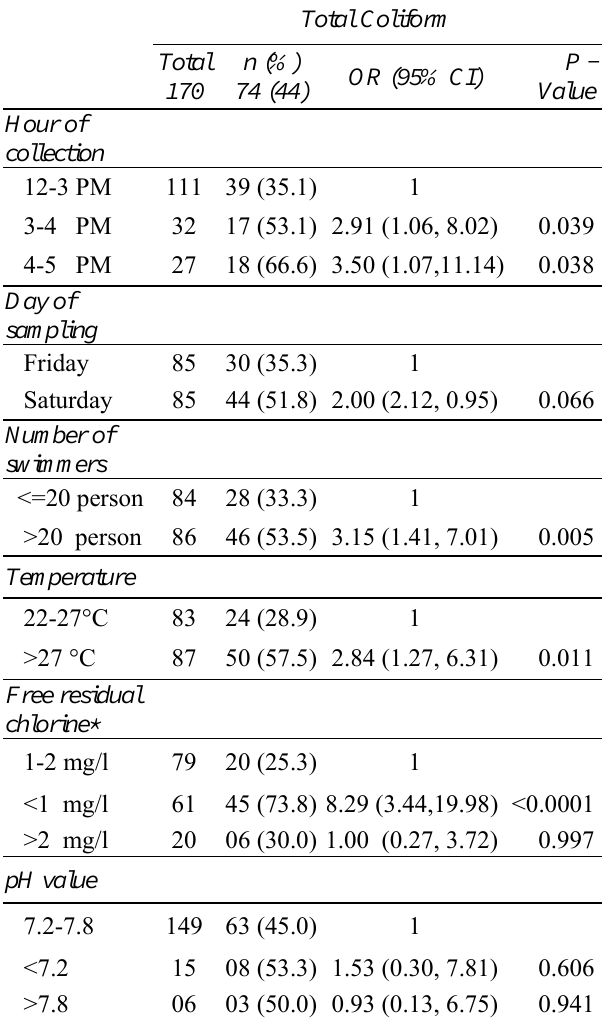
Table 3: Multivariate analysis of factors associated with contamination by Total